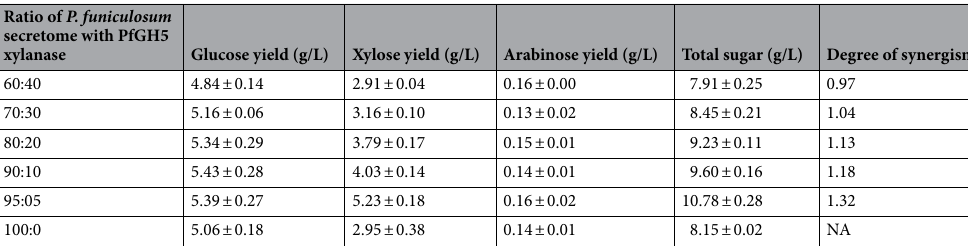
Table 3. Degree of synergism of P. funiculosum with Pf GH5 xylanase in SCB saccharification. A DS higher than one indicates there is cooperation among the involved enzymes while DS lower than one indicates there is competition between the involved enzymes. NA not